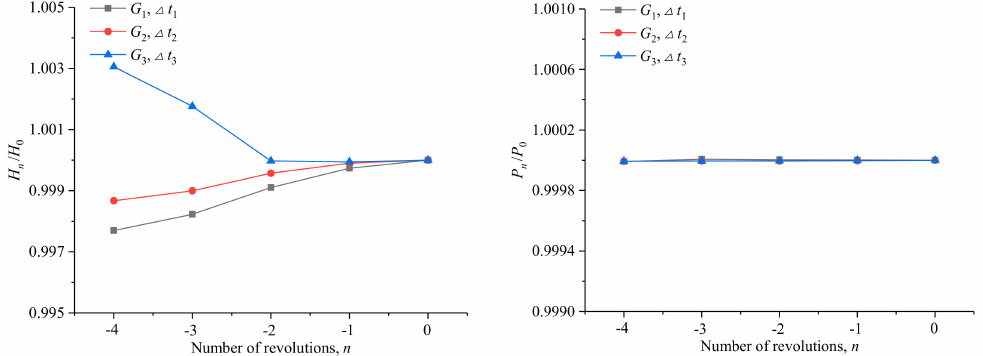
Figure 9. The convergence history of the averaged head H ( left ) and power P ( right ) in the last five revolutions before convergence, Q = 0.42 m 3 /s. The abscissa, n , denotes the number of revolutions relative to the last revolution ( n = 0). The ordinates H n and P n denote the head and power of the n th revolution,